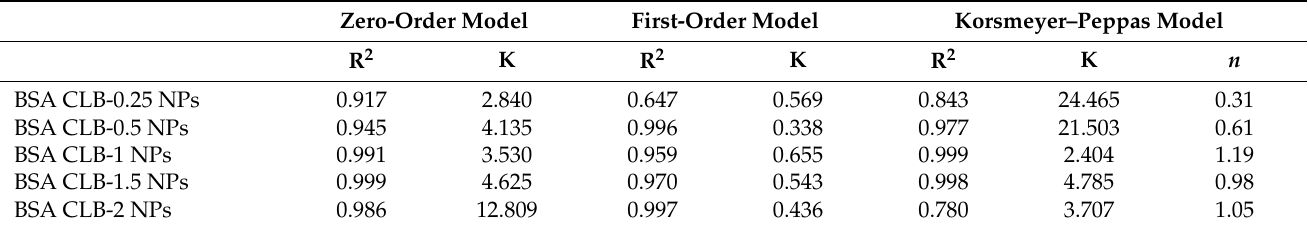
Table 2. Release kinetics of CLB from BSA NPs system.